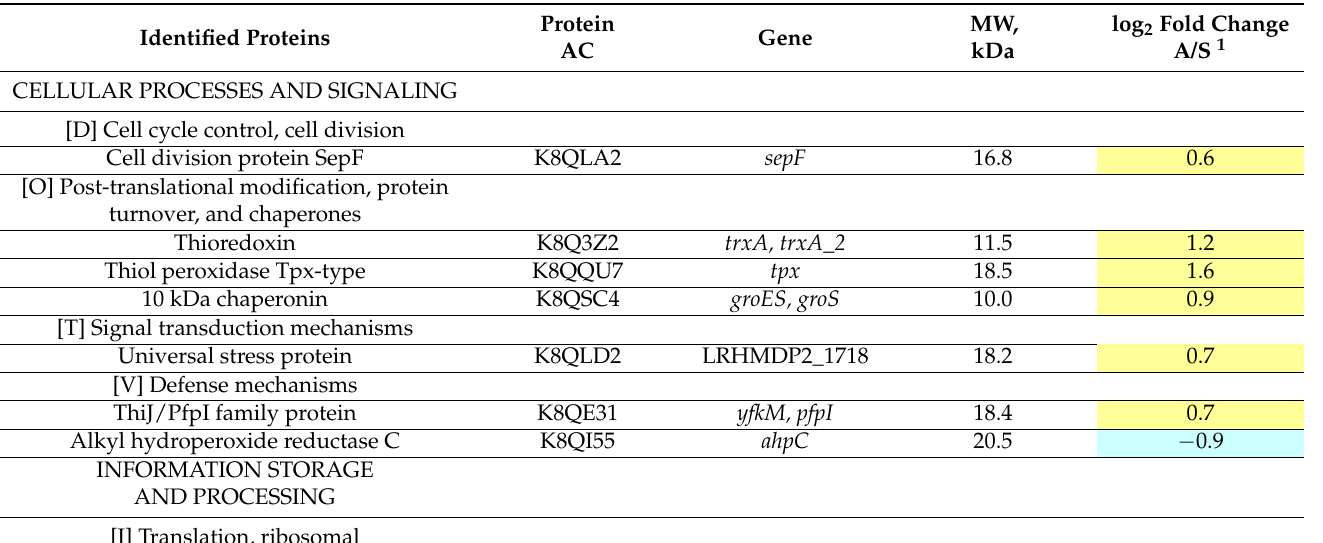
Table 1. Differentially expressed proteins of L. rhamnosus CM MSU 529 in aerobic conditions compared to static